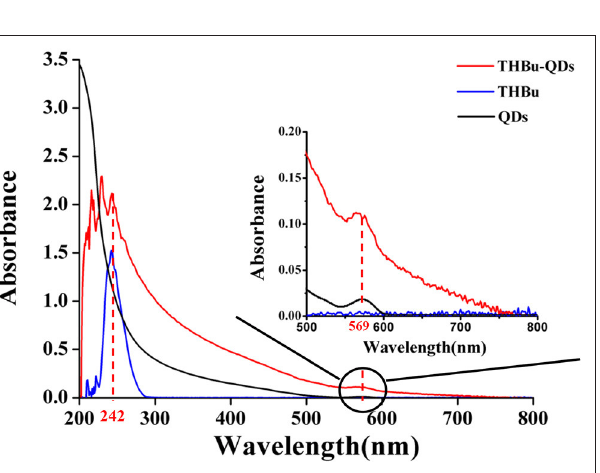
In spectra (c), the peaks at 1,639 cm − 1 (C = O), and